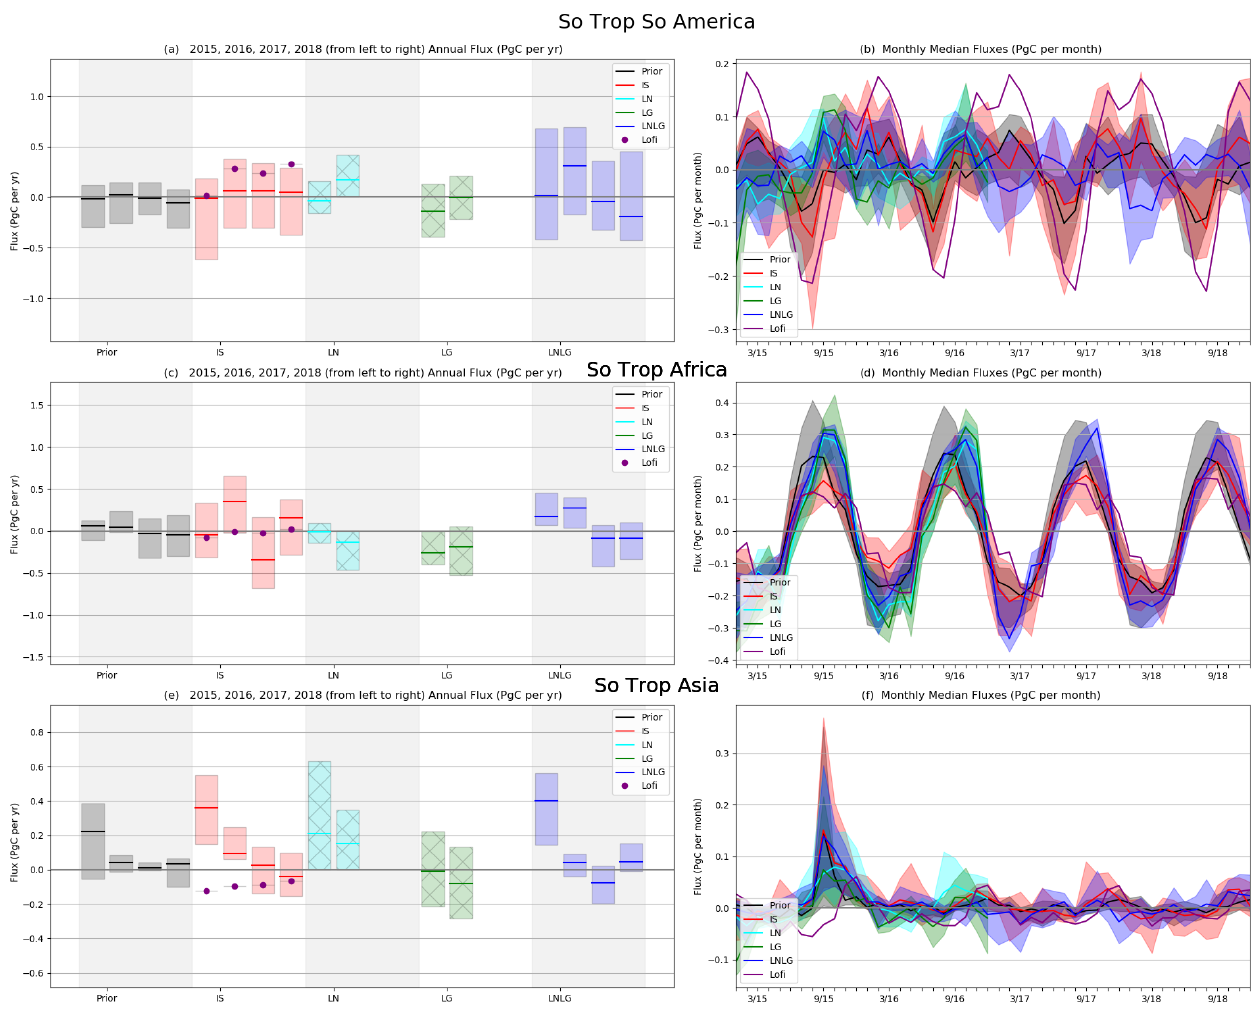
Figure 11. Same as Fig. 6 but for the southern (So) tropical regions: southern tropical South America (a, b) , southern tropical Africa (c, d) , and southern tropical Asia (e, f)